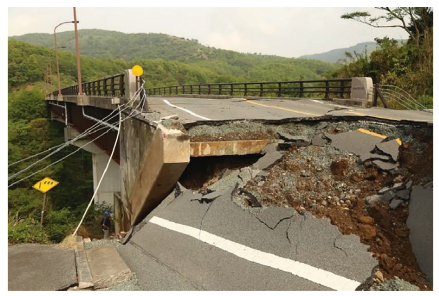
Figure 14: Damage to abutment A1 (exterior).